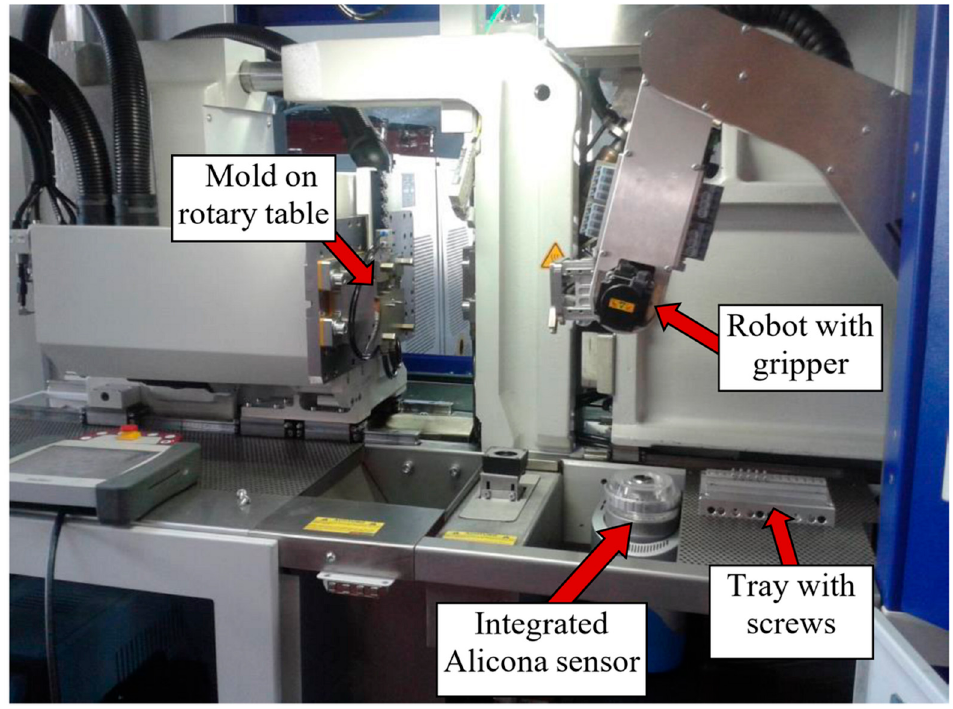
Figure 15. Processing setup: mold on rotary table, integrated Alicona sensor, tray with screws prepared for inserting and overmolding and robot with gripper.